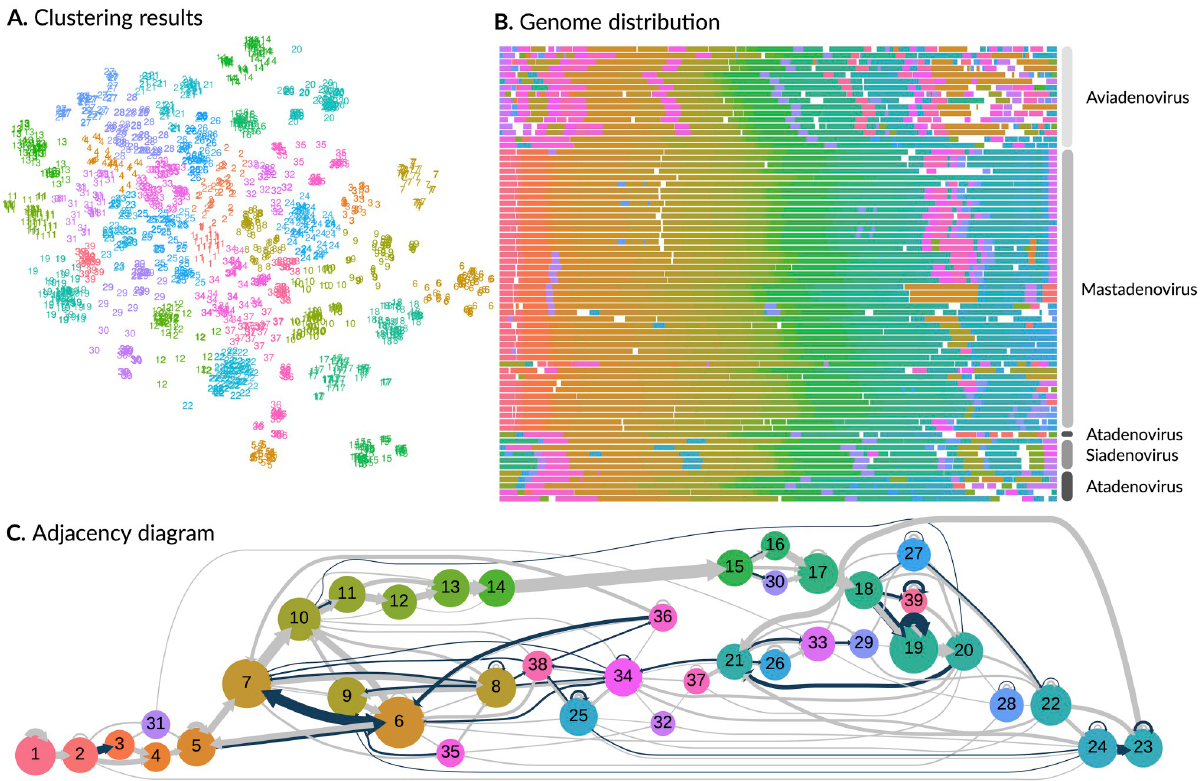
Fig 3. Adenoviridae family analysis. A . t-SNE projection of protein sequences from n = 71 genomes in the Adenoviridae. Each point represents a protein sequence, coloured and numbered by its cluster assignment. Based on our clustering criteria, we identified a total of 39 clusters for this virus family. B . A compact representation of reference genomes labeled by genus. Each set of line segments represent the coding sequences of a genome, coloured by cluster assignments and rescaled to a constant total length. White spaces represent non-coding regions. C . A hierarchical layout of the adjacency graph for Adenoviridae. Each node represents a cluster of homologous coding sequences, scaled in proportion to the number of sequences in the cluster. Node numbering and colours were determined by the order of appearance of clusters in the data. Directed edges (arrows) connect nodes representing coding sequences that are adjacent in five or more genomes. Edges are coloured blue if the genes overlap and grey otherwise; widths are scaled in proportion to the number of genomes in either case. This diagram was generated using Graphviz and arrows were manually modified in